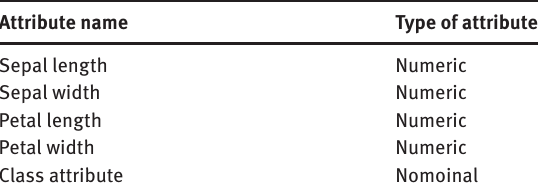
Table 1: Data set